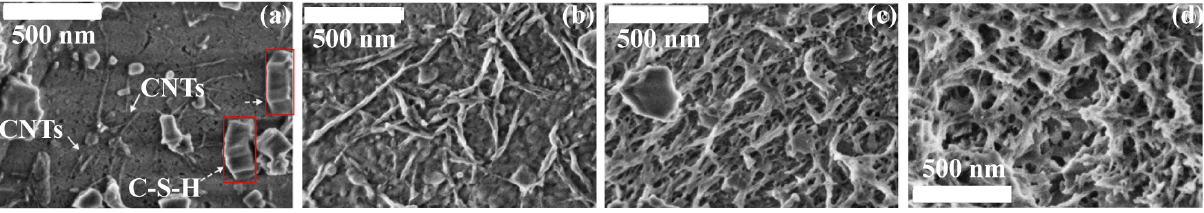
Figure 5: Distribution of calcium silicate hydrate (C-S-H) gel in a CNT-cement system after hydration for (a) 60 min; (b) 135 min; (c) 180 min; (d) 240 min